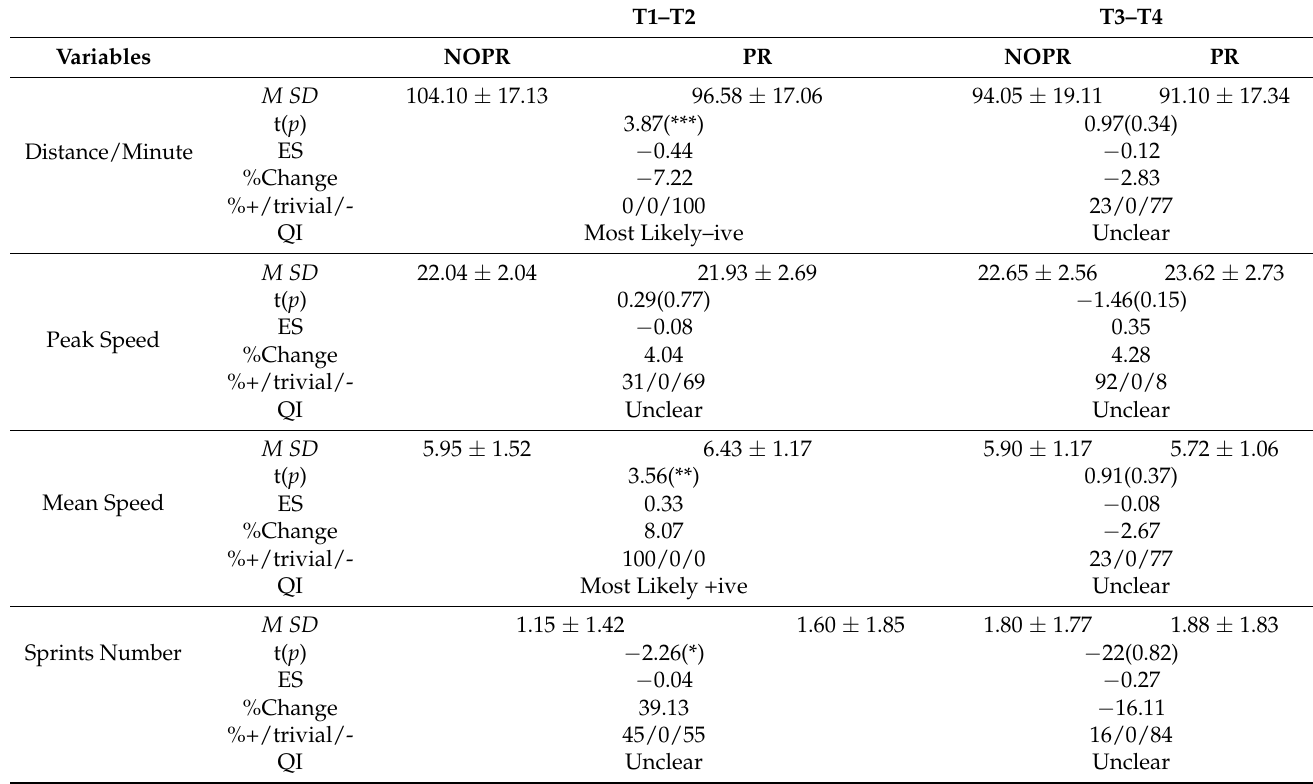
Table 3. External physical load results between pairs of